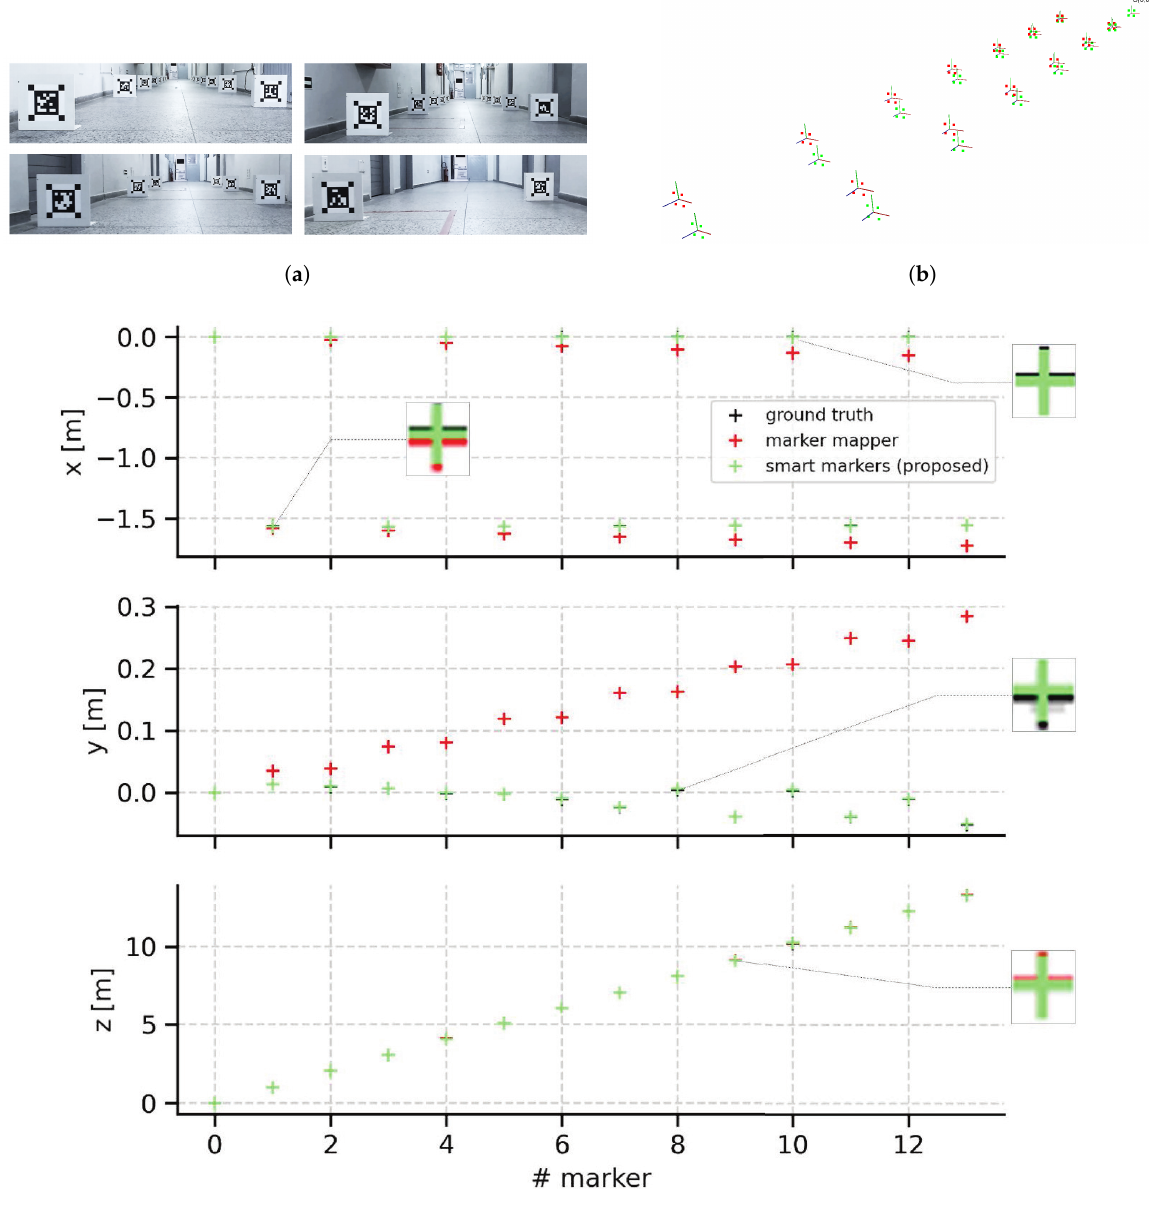
Figure 14. Evaluation of the mapping stage with smart markers with dataset M-Seq1/hall . Snapshots of smart markers distributed on the environments ( a ). Marker maps comparison ( b ). Three-dimensional reconstruction ( c ) in which red plus markers represent the Marker Mapper position estimates, green markers represent smart marker (our method) position estimates, and black are ground truth position